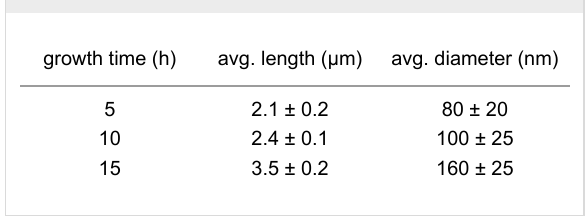
Table 1: Dimensions of the ZnO nanorods.